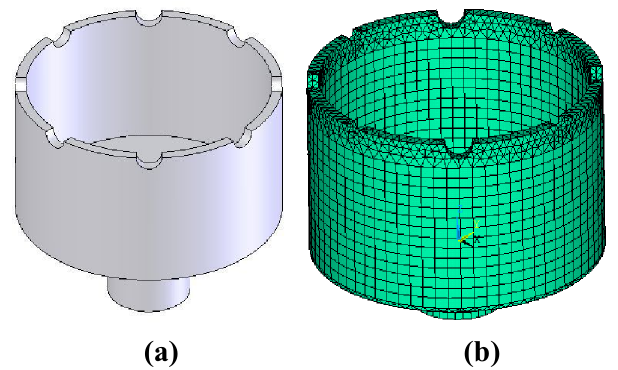
Figure 5. (a) Entity mode of the cylinder resonator. (b) Meshed model of the cylinder